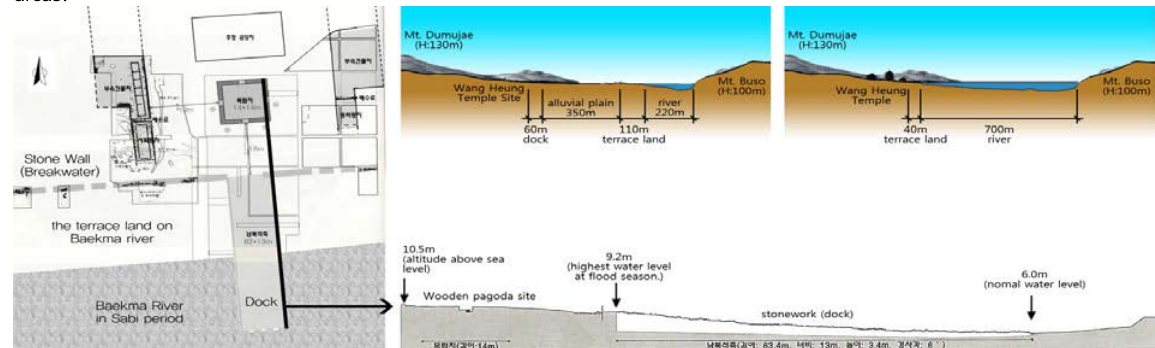
Figure 3. Wang-Heung temple ruins and the relative position of the ancient water level